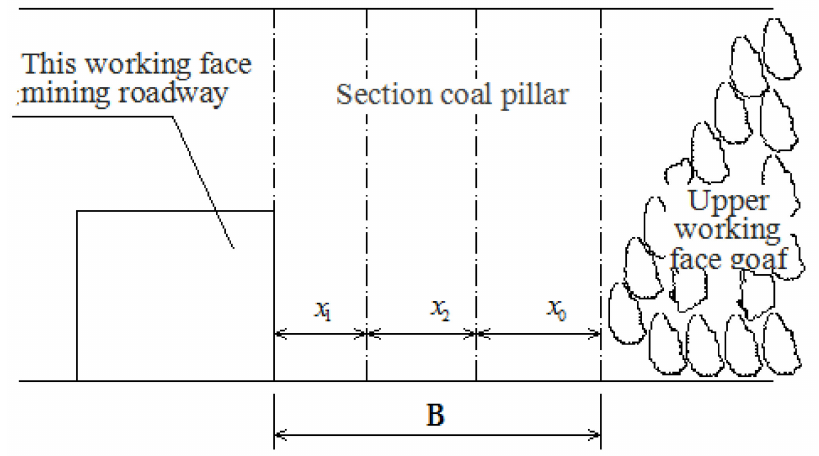
Figure 5. Calculation diagram of the small coal pillar size in the